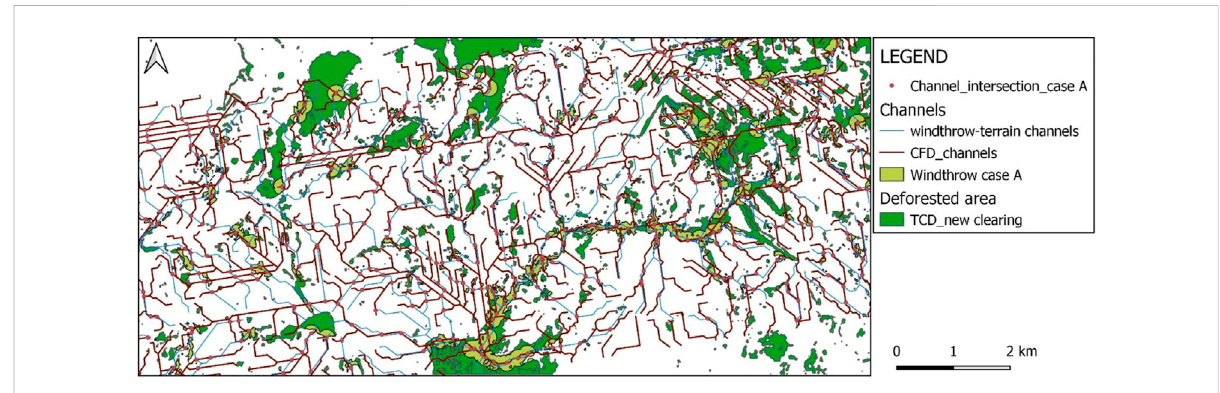
FIGURE 9 Case A — damaged stands at the intersection of terrain and CFD-generated channels.